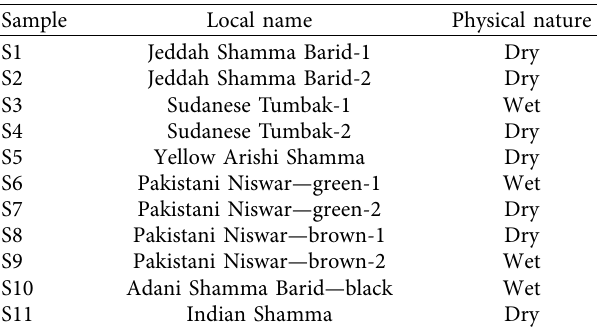
Table 1: Local names and physical nature of SLTsamples of Tabuk